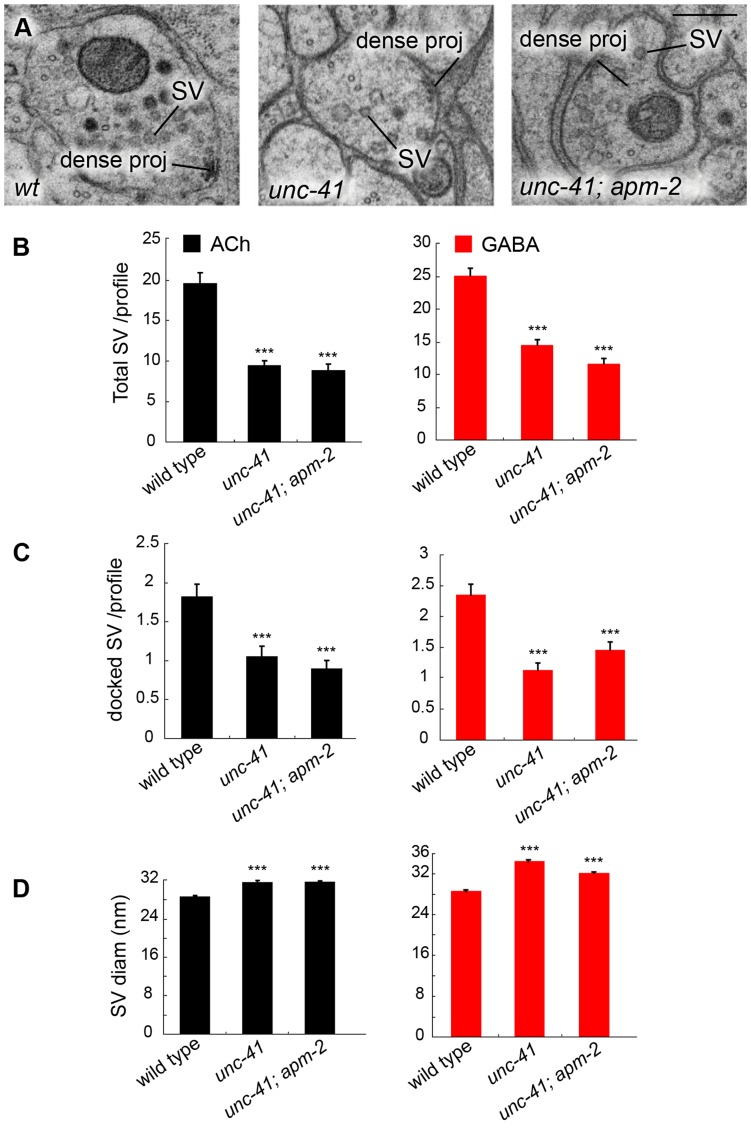

unc-41 mutants have fewer synaptic vesicles at synapses.(A) Representative images of neuromuscular junctions in ventral nerve cords of the wild type, unc-41(e268), and unc-41(e268); apm-2(e840) strains. Scale bar is 200 nm. SV, synaptic vesicle. (B) The total number of synaptic vesicles is reduced in unc-41 and unc-41; apm-2 mutants. (C) The number of docked synaptic vesicles is reduced in unc-41 and unc-41; apm-2 mutants. (D) Vesicle diameters are slightly increased in unc-41 and unc-41; apm-2 mutants. All data were obtained exclusively from profiles containing a dense projection. Values in panels B, C, and D represent means; error bars indicate SEM. The number of synapses scored in Panels B and C for wild type, unc-41, and unc-41; apm-2 were 38, 40, and 30, respectively for ACh synapses, and 36, 45, and 39, respectively for GABA synapses. The number of synaptic vesicles measured for the data in panel D for wild type, unc-41, and unc-41; apm-2 were 733, 380, and 265, respectively for ACh synapses, and 904, 652, and 453, respectively for GABA synapses. Triple asterisks denote significant difference from wild type (P<0.001).